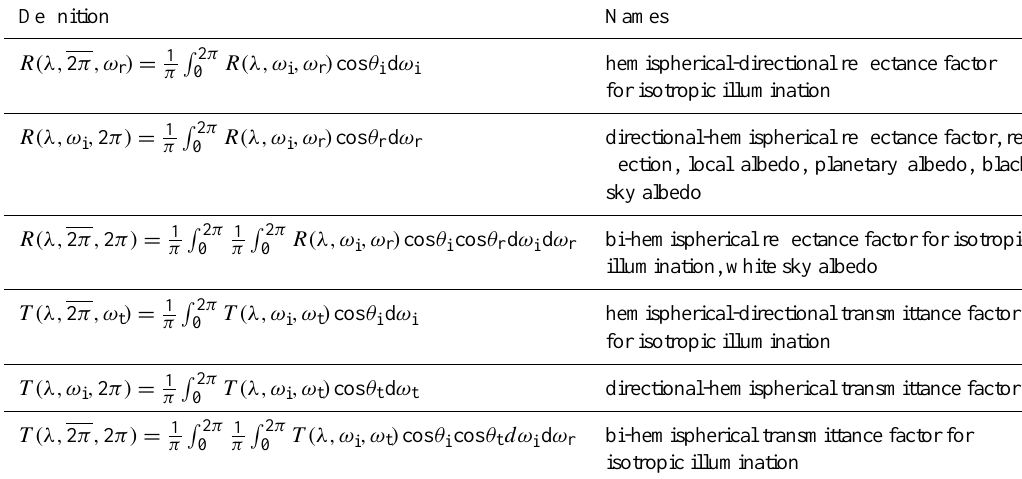
Table 1. Definition of reflectance and transmittance terms. Additional transmittance terms can be created by the inclusion of the direct transmittance (the unattenuated beam) to give total transmittance terms for a layer.